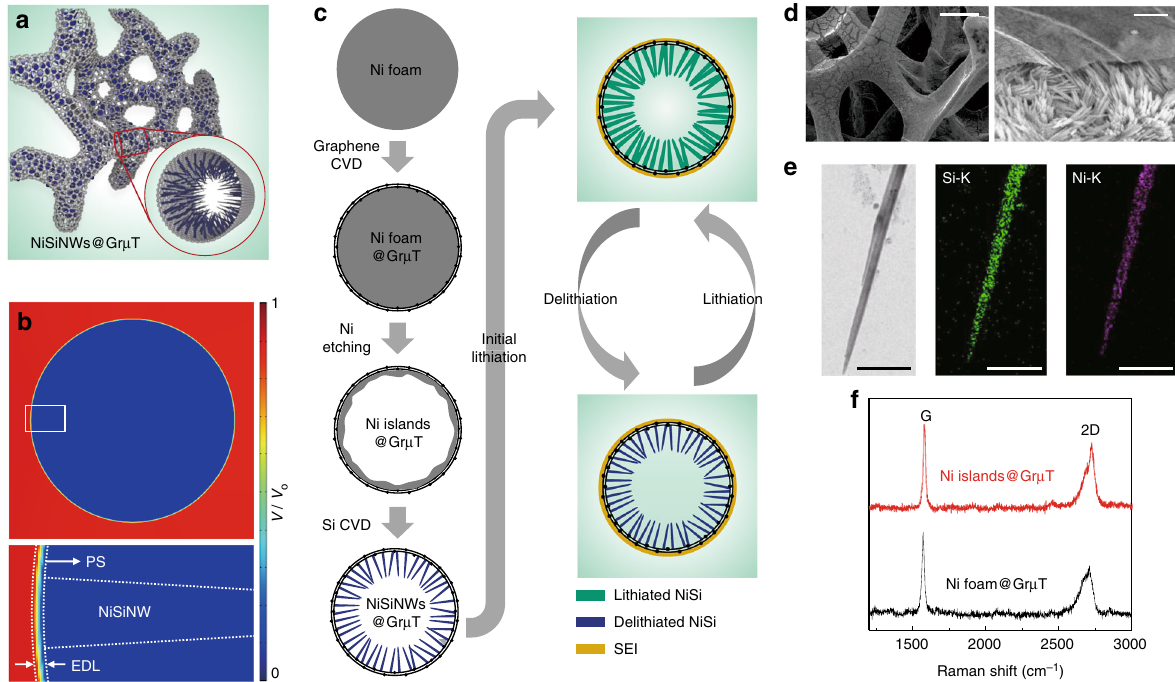
Fig. 2 Fabrication and structural analyses of NiSiNWs@Gr μ T. a Schematic of NiSiNWs@Gr μ T. b Simulation of the potential distribution across the NWs@Gr μ T with an SEI layer on the outer surface of the Gr μ T. Bottom panel: enlarged images taken from the square in the top panel showing that the formation of the SEI on the outer surface of the Gr μ T occurred through the development of a rapid potential gradient. A voltage difference of V o was applied between the left-hand electrolyte and Gr μ T, and the calculated position-dependent potential values were normalized with respect to V o . c Schematic of the fabrication process of NWs@Gr μ T (left) and lithiation-delithiation cycling (right). SEI formation and Li-ion insertion/extraction only occur around the outer surface of the Gr μ T. d SEM images of as-fabricated (left) and cross-sectioned (right) NiSiNW@Gr μ T. Scale bars, 50 μ m (left) and 2 μ m (right). e TEM image of NiSiNW (left) and EDS elemental mapping images of Si (middle) and Ni (right). A Ni to Si atomic ratio of ~1:1 was con fi rmed by EDS composition analysis. Scale bars, 400nm (left) and 250 nm (middle and right). f Raman spectra of the Gr μ T before (black) and after (red) core